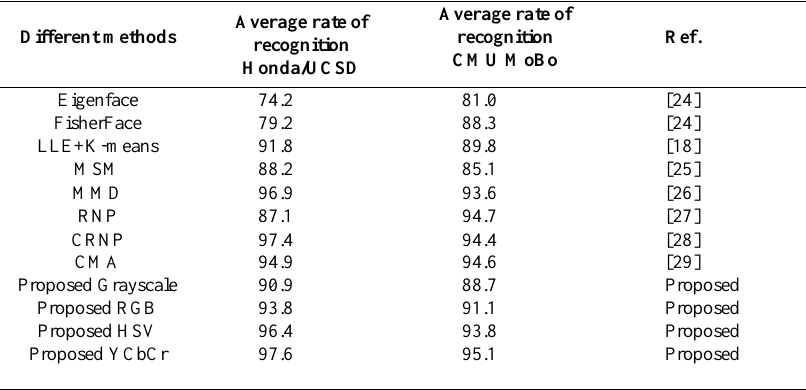
Table 1. Average recognition rate by different color spaces in Honda /UCSD database and CMU MoBo